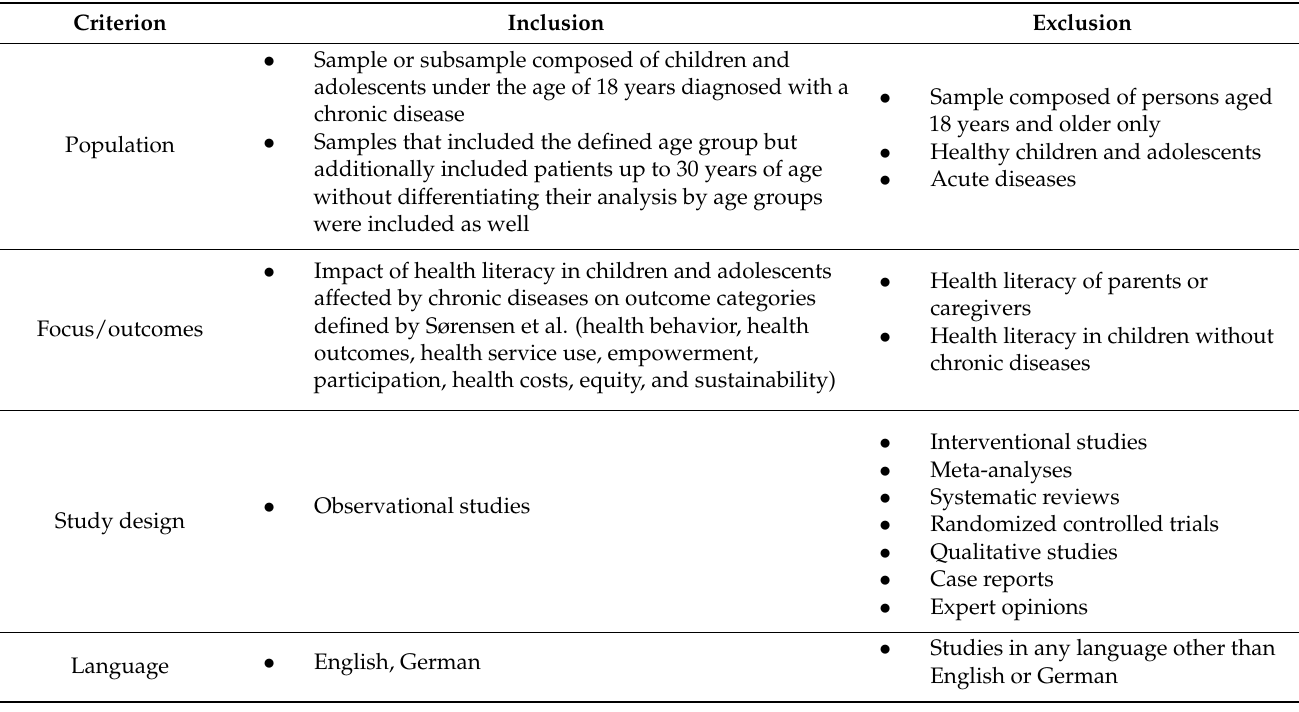
Table 1. Eligibility